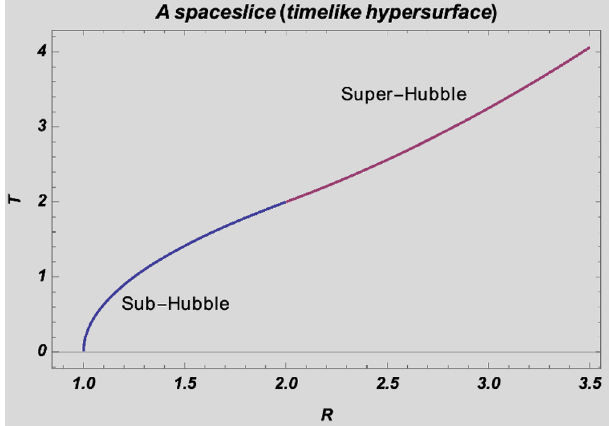
Figure 4 . A constant cosmic space ( r = r 0 ) slice in the cosmological ( T, R ) plane (the depicted p slice has r 0 = 2 / H e ). The r = r 0 slice in the sub-Hubble region is the upper portion to the SLR of the parabola (4.9) (showed by the blue curve), while the super-Hubble region is foliated by the parabola (4.10) (only the portion left to the SLR, showed by the purple curve). They also intersect at the Hubble radius at T = R where (4.9) and (4.10) are identical parabolas. This is the worldine p of the cosmological static observer at r = r 0 = 2 / H e while looked upon in T, R